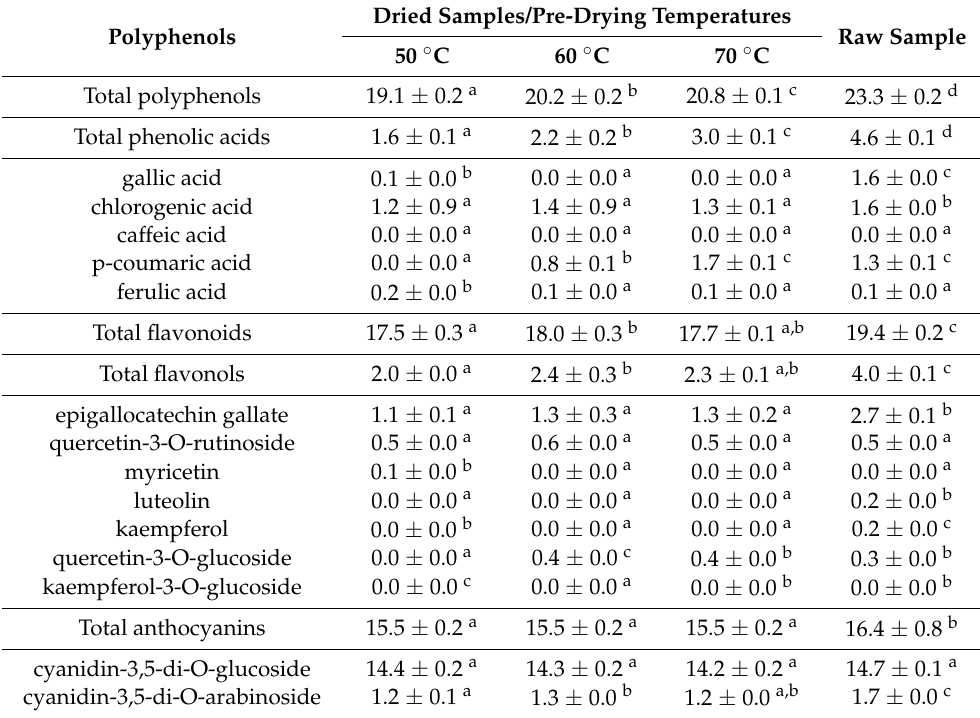
Table 4. Individual polyphenol content (mg/g d.m.) determined using HPLC method in chokeberry FBJD powders obtained by using pre-drying at three temperatures of 50, 60, and 70 ◦